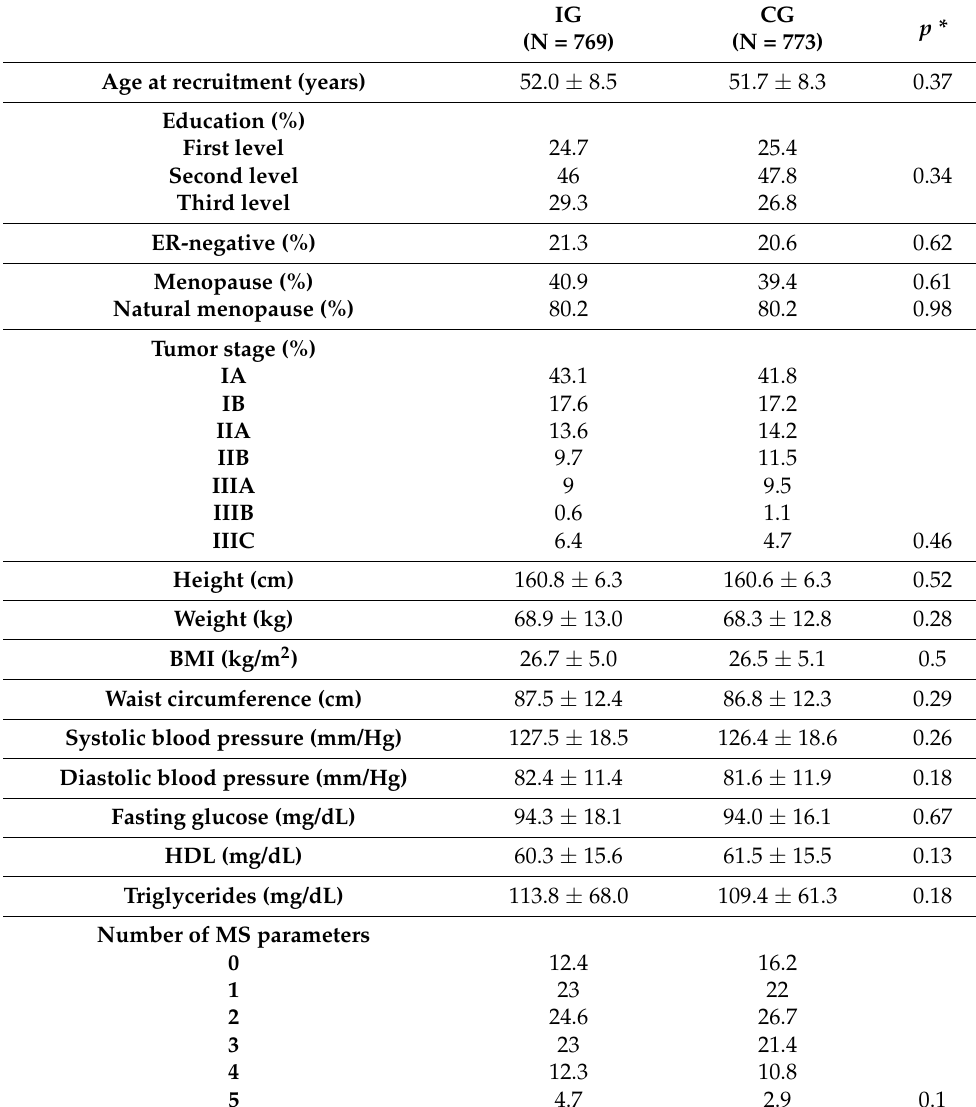
Table 1. Baseline metabolic and anthropometric characteristics of the study population by random- ization